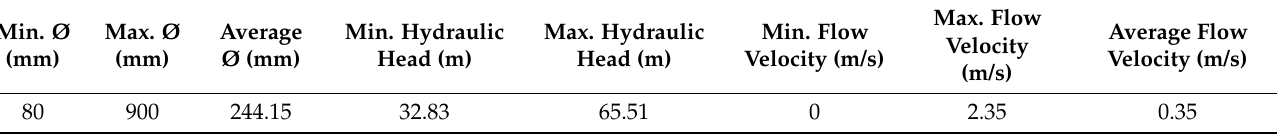
Table 3. Hydraulic characteristics of the Cheongna WDN Table 2. Main characteristics of the Cheongna WDN model.